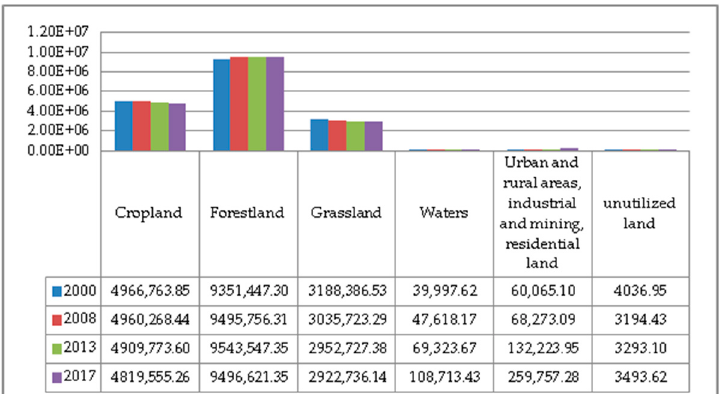
Figure 1. Map of Guizhou Province, China.